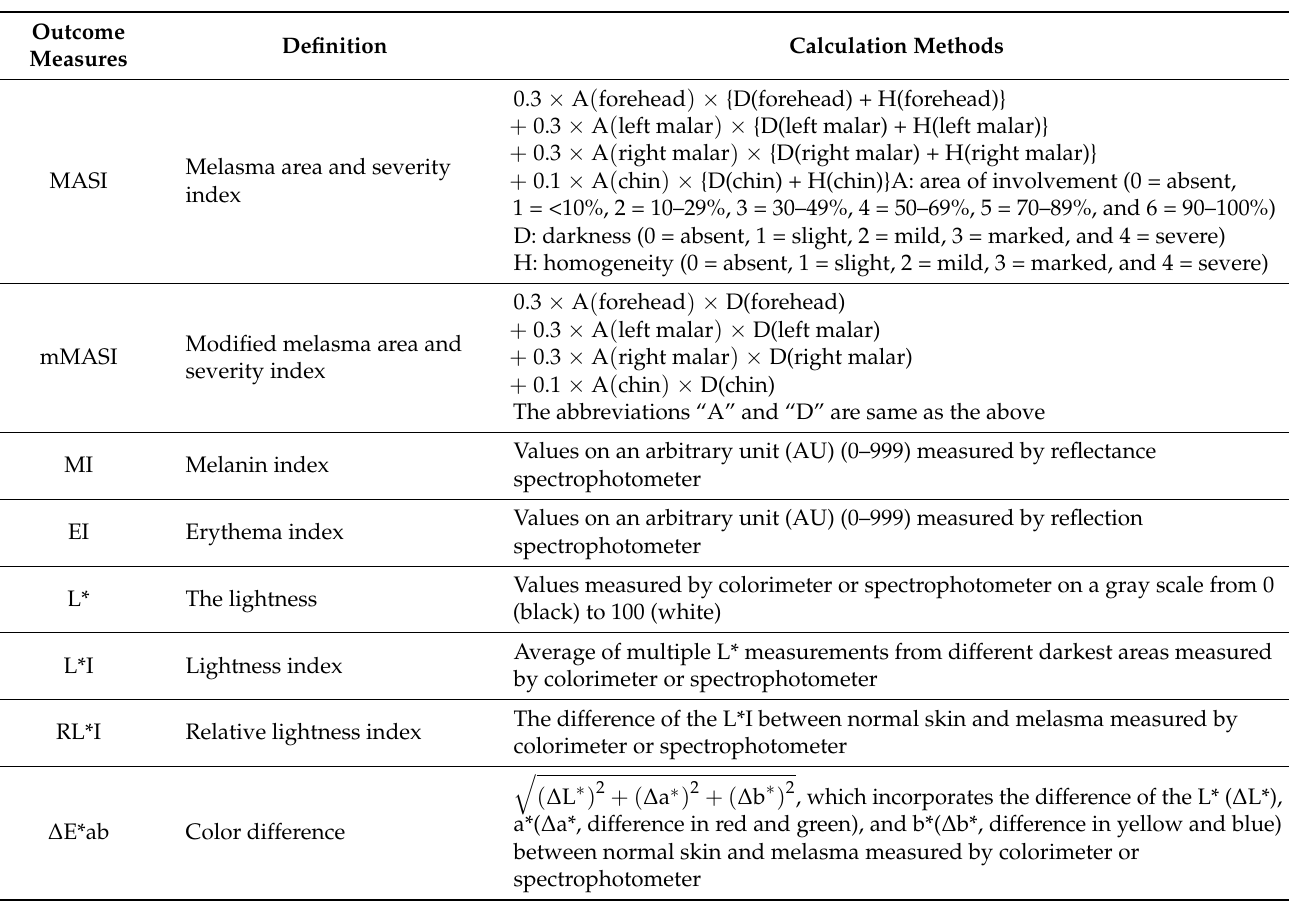
Table 2. Summaries of the commonly used outcome measures for evaluating